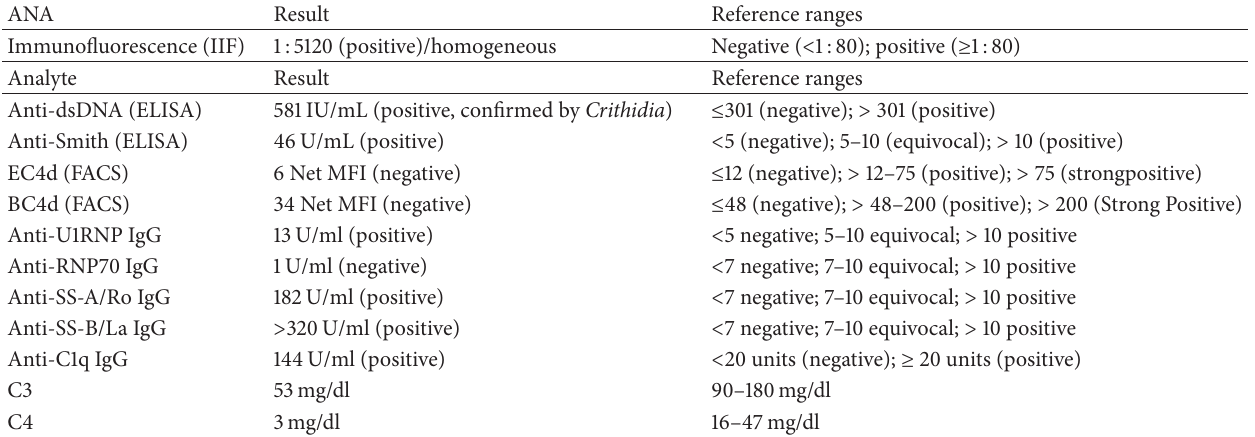
Table 1: July 09,